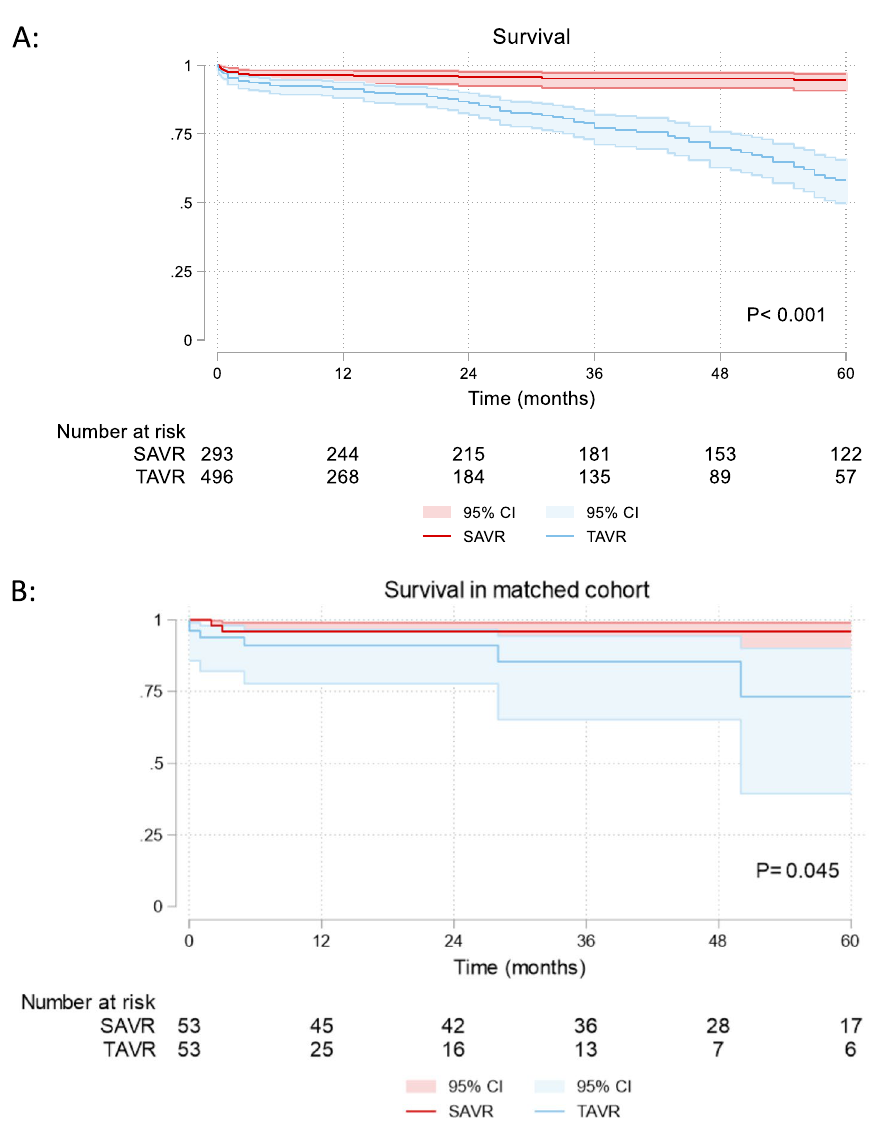
Fig. 1 A Kaplan-Meier survival curve in all cohort. B Kaplan-Meier survival curve after matching (SAVR, surgical aortic valve replacement; TAVR, transcatheter aortic valve